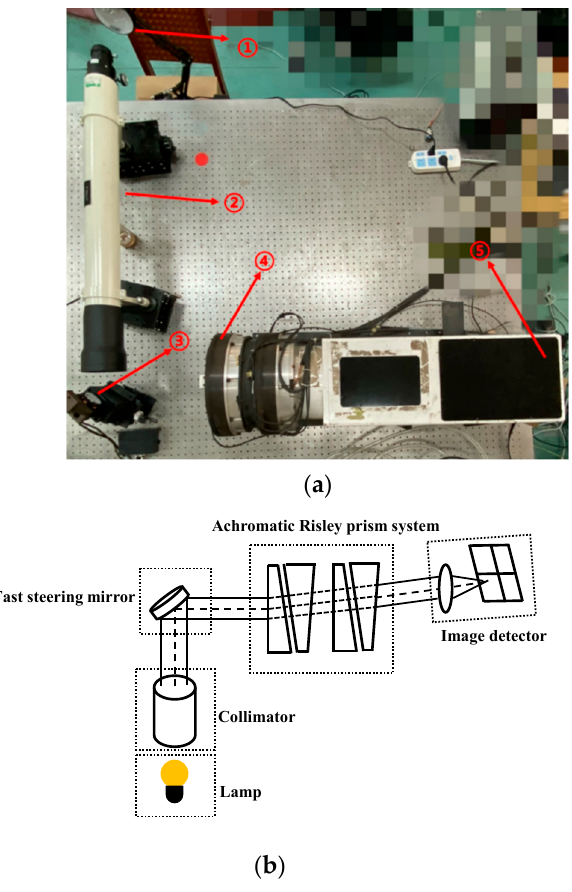
Figure 9. Experimental platform. ( a ) Main components of the experimental platform: ① lamp, ② collimator, ③ fast steering mirror, ④ achromatic Risley prism system, and ⑤ image detector. ( b ) Optical propagation scheme of the experimental platform.